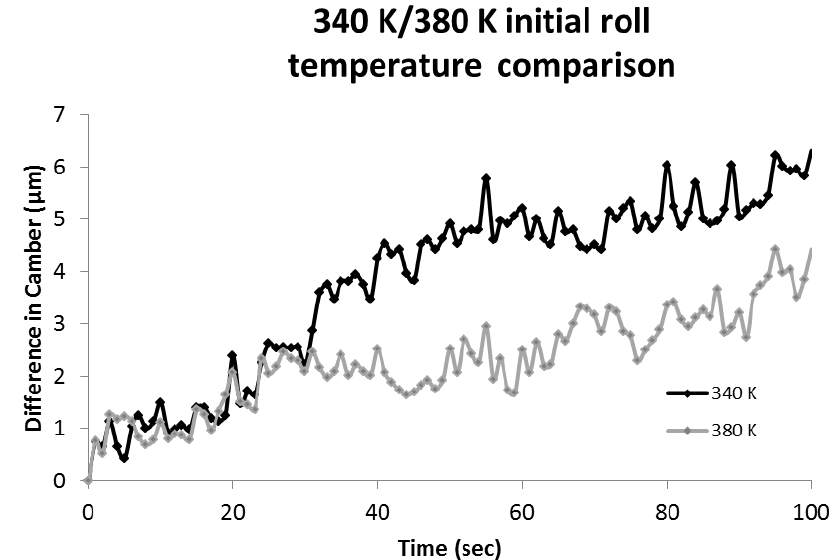
Figure 9. Comparison of camber evolution between rolls with 340 Κ και 380 Κ initial temperature.